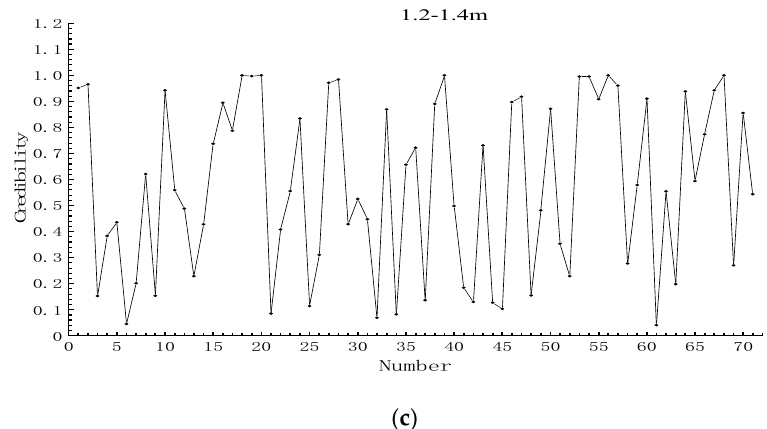
Figure 9. Distribution of credibility in different intervals. ( a ) Distribution of credibility in the 1.0–1.1 m interval; ( b ) distribution of credibility in the 1.1–1.2 m interval; ( c ) distribution of credibility in the